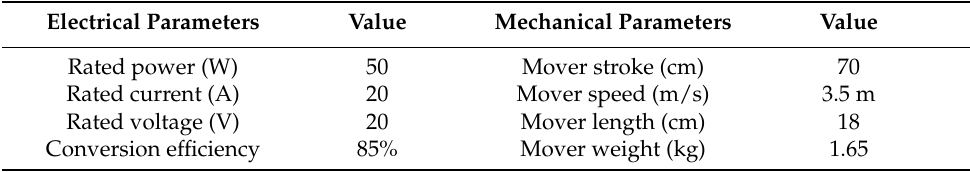
Figure 2. Experimental bench: ( a ) Framework; ( b ) Hardware: 1. Rotating motor; 2. Linear motor; 3. Driver; 4. DC power; 5. Switch; 6. Rectifier; 7. Acquisition board; 8. Electronic load; 9. DC power; 10. Computer; 11. RT-LAB. Table 1. Specifications for wave energy linear